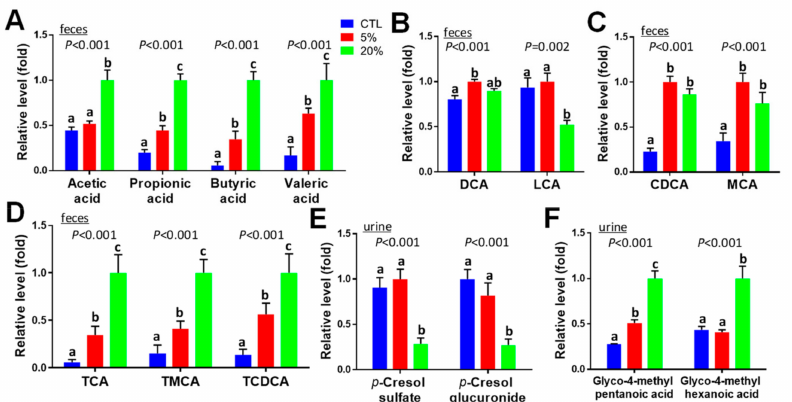
Figure 8. E ff ects of Scenedesmus feeding on microbial metabolites. ( A ) Short chain fatty acids (SCFAs) in feces. ( B ) Secondary bile acids in feces. ( C ) Primary bile acids in feces. ( D ) Taurine-conjugated bile acids in feces. ( E ) p -cresol metabolites in urine. ( F ) Glycine conjugates of branched fatty acids in urine. P -values indicate overall significances across all sample groups from the one-way ANOVA test. Means with di ff erent letter labels (a,b,c) indicate significant di ff erences ( P < 0.05) between two dietary treatments by the Tukey post hoc